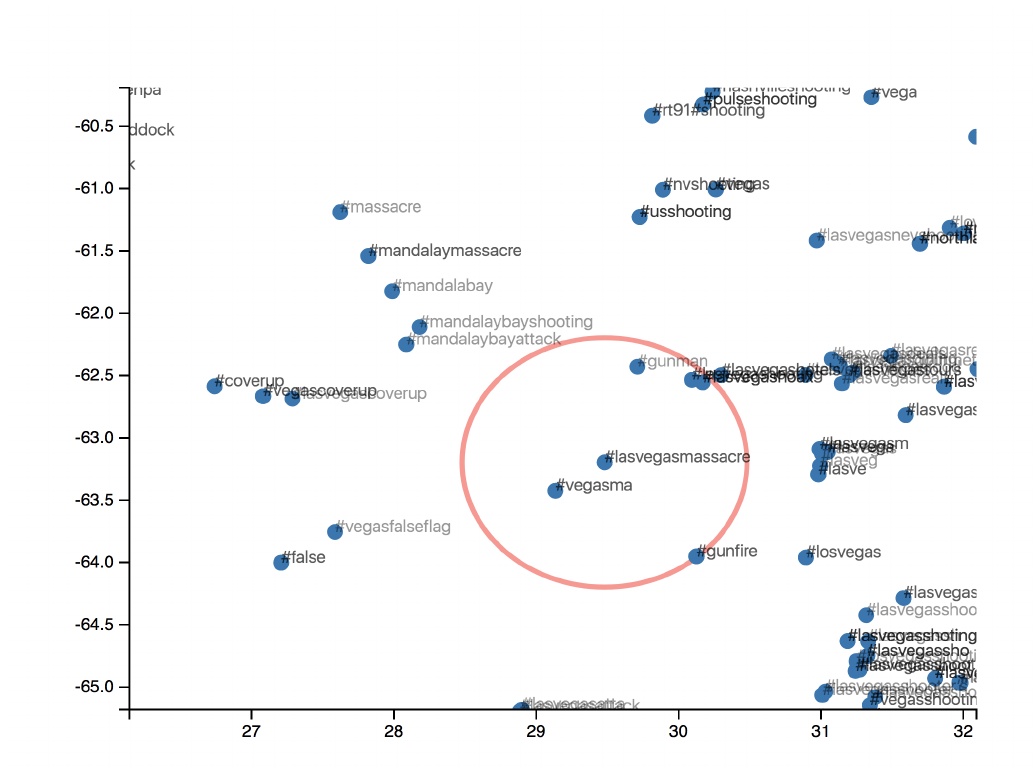
Figure 5. Interactively visualizing hashtags using unsupervised text embeddings and t-SNE dimensionality reduction. The units and numbers on the axes are without semantics, and are for visualization purposes